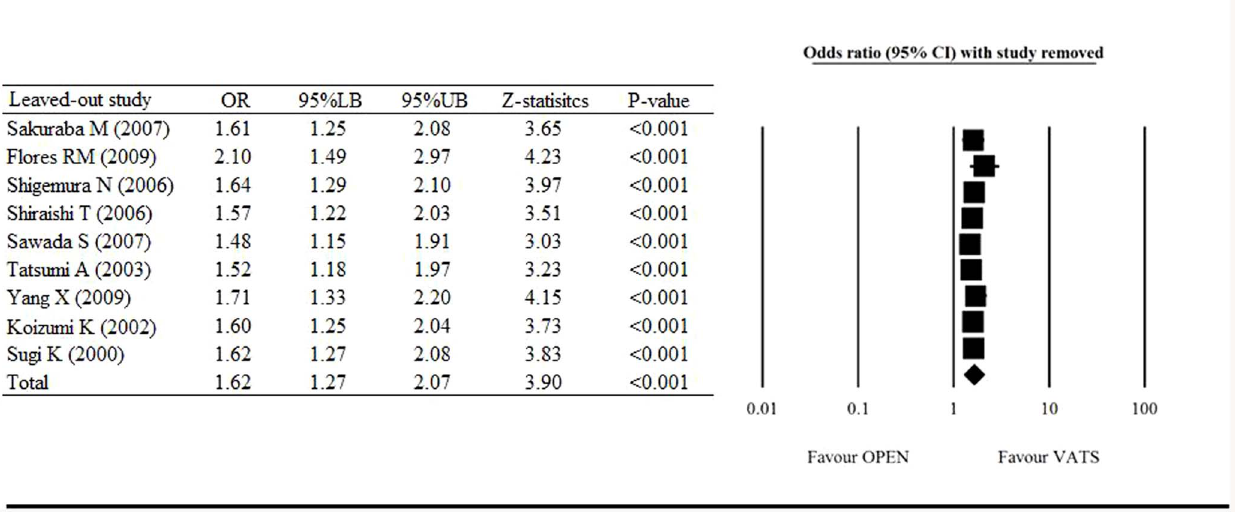
Figure 2. Sensitivity analysis of the influence of individual studies on pooled estimate for 5-year survival rate. OR, odd ratio; LB, lower boundary; UB, upper boundary; CI, confidence interval.